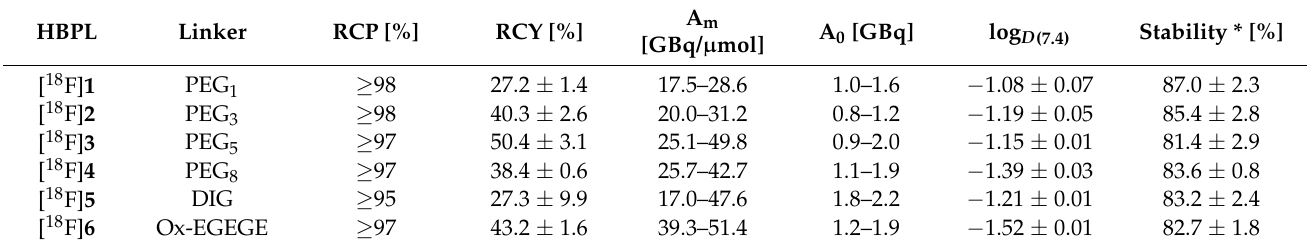
Table 1. Summary of the results from 18 F-radiolabeling and in vitro log D (7.4) and stability evaluations. A 0 : starting activity. Values are given as mean ± SD (standard deviation).